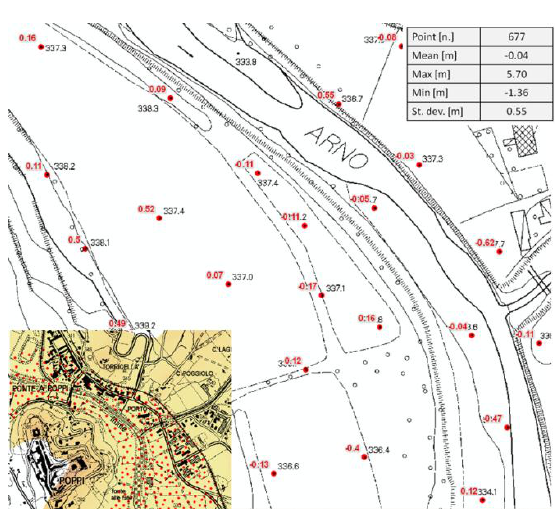
Figure 2. CTR 1:10000 and DTM interpolated height comparison